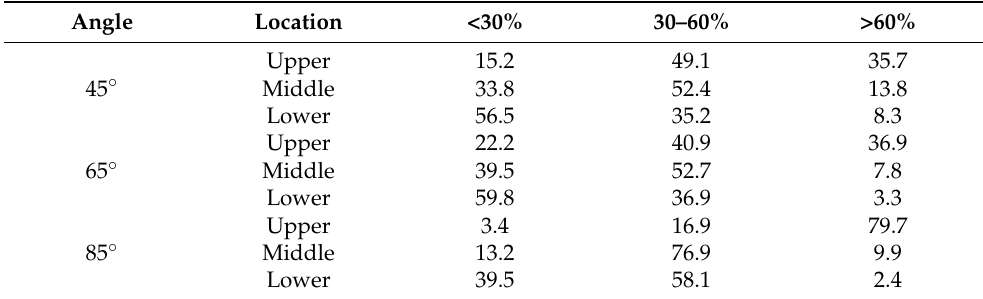
Table 3. The proportion of light intensity under the different opening angles of the main branches in the early stage of crown formation